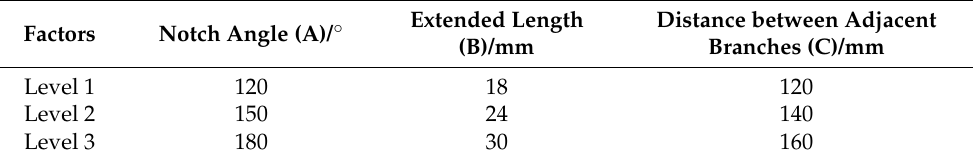
Table 1. Experimental factors and levels for orthogonal test.